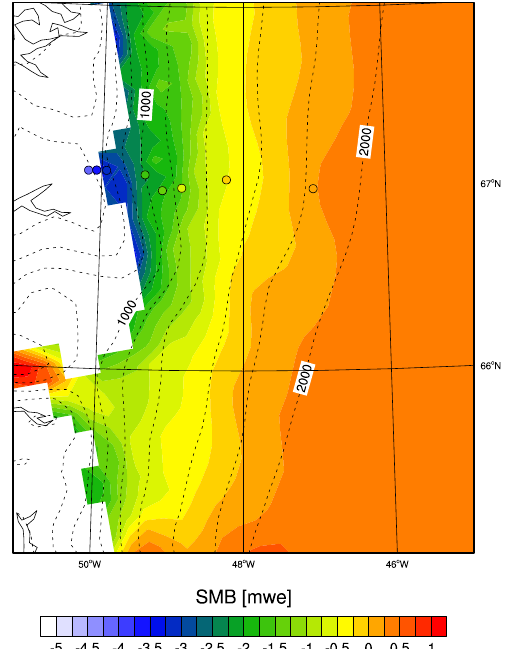
Fig. 10. Average surface mass balance for the period 1991–2010 in the K-transect region. The dots represent stake measurements. Height contours every